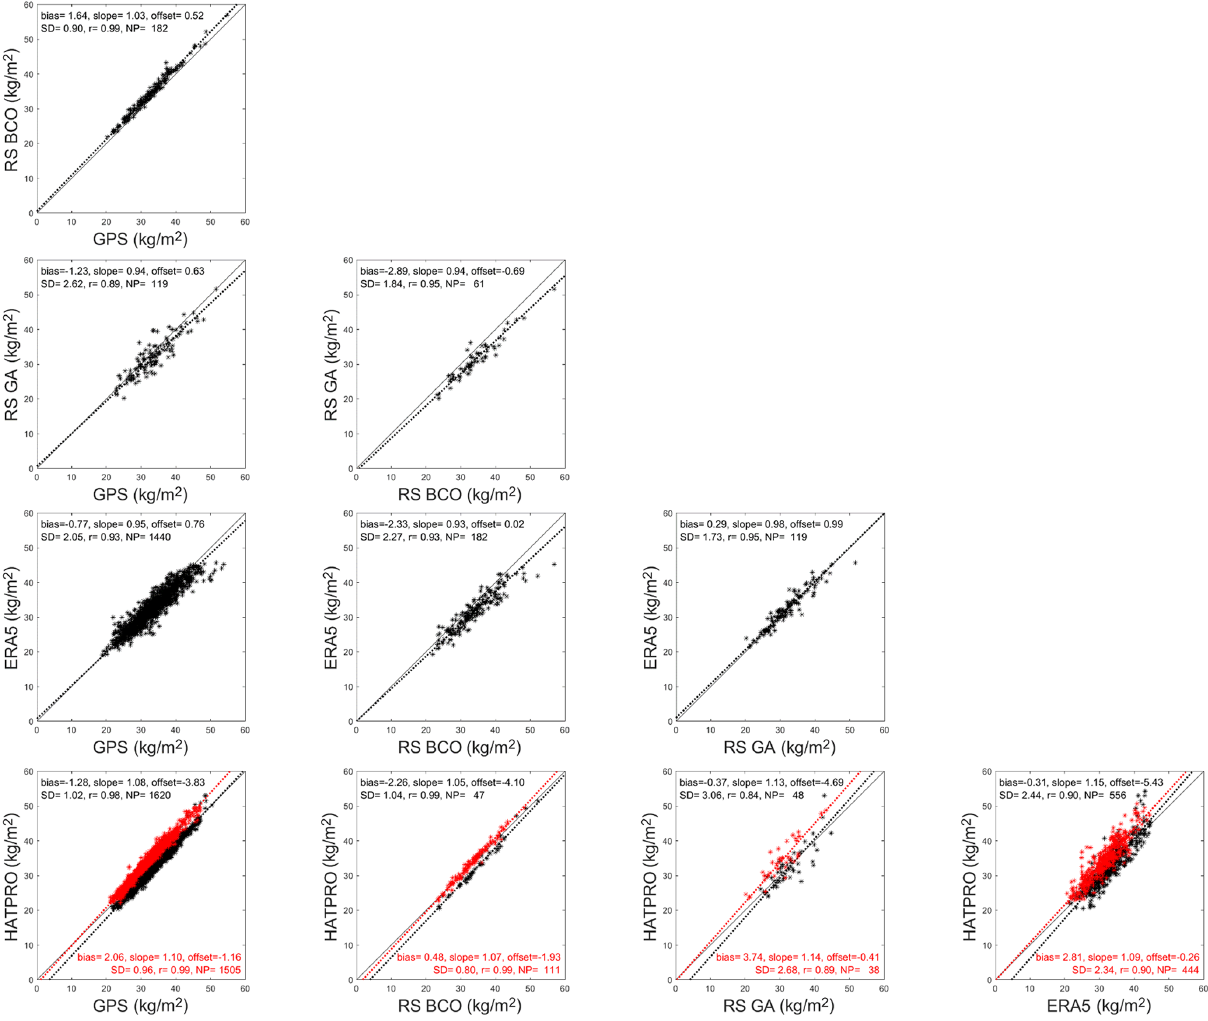
Figure 6. Pairwise scatter diagrams of IWV estimates from GNSS station BCON (GPS), HATPRO MWR, Vaisala RS41 radiosondes released from the BCO (RS BCO), operational radiosondes released from Grantley Adams International Airport (RS GA), and ERA5 reanalysis. The HATPRO data set has been separated in two parts: before (black symbols) and after (red) 27 January when the system was fixed for an instrumental failure. Note that sample sizes are different between diagrams because each comparison is done with the highest temporal resolution for the period of available data between 1 January and 29 February